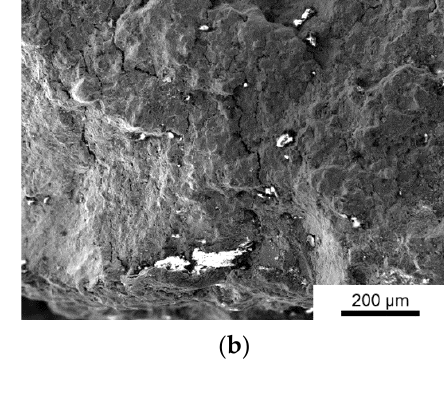
( d ) Figure 15. Fractography of ZnAl-coated (II) specimen tested in 3.5% NaCl solution at 300 MPa and: ( a ) overview, ( b ) area of crack initiation, ( c ) area of sudden failure and ductile dimple fracture and ( d ) area of sudden failure and ductile dimple fracture at higher magnification. 4. Conclusions and Outlook The combination of twin wire arc spraying (TWAS) and machine hammer peening (MHP) resulted in coating thicknesses above 200 µm, covering the entire substrate mate- rial S355 J2C + C without cracks vertical to the substrate. MHP improved the roughness of the ZnAl coatings with a reduction of the arithmetical mean roughness and mean roughness depth by over 50%. The MHP process also created a more consistent coating thickness throughout the specimen and less porosity. Direct correlations of material reactions by means of mechanical and electrochemical measurement techniques and corrosion fatigue damage mechanisms were determined for the three conditions: sandblasted (I), ZnAl-coated (II), and MHP post-treated (III). Higher total strain amplitudes for higher stress amplitudes lead to a more significant change in the open circuit potential (OCP). As a result of plastic deformation, newly generated sur- face gets in contact with the electrolyte and reduces the OCP in case of the coating systems II and III. Therefore, the initial decrease in OCP of MHP-treated (III) samples is expected to be related to the change in coating properties due to deformation, microcrack for- mation, and crack propagation within the coating. A significant increase of OCP for ZnAl- coated (II) and MHP post-treated (III) specimens indicated crack propagation, which reached the substrate steel. Further increase in OCP is a result of more substrate material in contact with the electrolyte due to crack initiation and propagation. The assumptions will be confirmed by interrupted corrosion fatigue tests to verify the relationship between cyclic deformation, fatigue crack mechanisms, and electrochemical measurements. ZnAl-coated (II) and MHP post-treated (III) coating systems significantly improved corrosion fatigue behavior at lower stress amplitudes (260 to 320 MPa) compared to sand- blasted (I) specimens. ZnAl coating (II) and MHP post-treatment (III) can increase the stress amplitude applied to achieve a defined lifetime compared to sandblasted (I) speci- mens. In the low cycle fatigue (LCF) regime, the corrosion fatigue performance of all con-